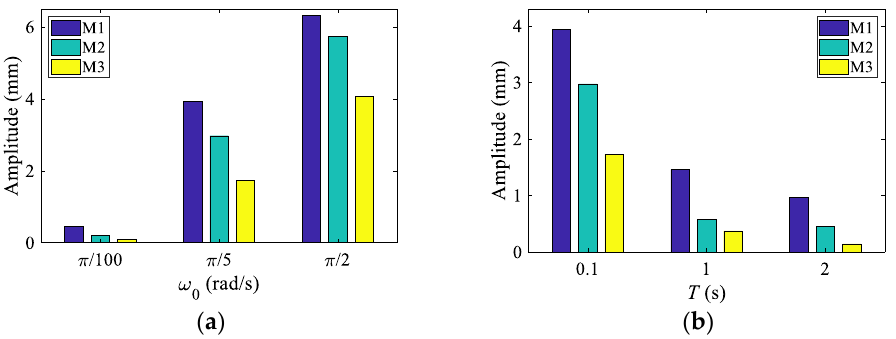
Figure 13. Relationship between vibration amplitude and rigid body motion of different models. ( a ) T = 0.1 s with different ω 0 ( b ) ω 0 = π/5 (rad/s) with different T. The blue, green, and yellow dotted lines in Figure 12 denote the natural frequencies of the dominant mode (fourth-order mode) of models M1, M2 and M3, which are 0.94 Hz,